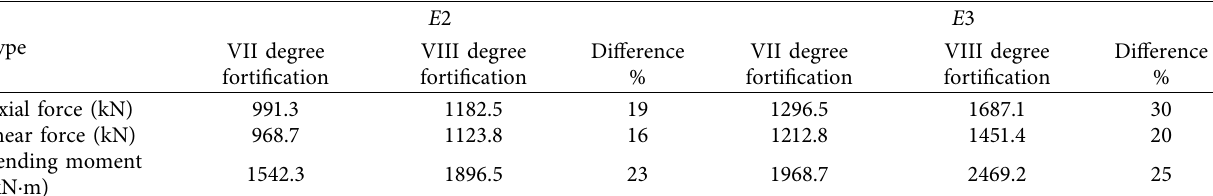
Figure 4: (a) The horizontal displacement and (b) the shearing strain of the station with the E 3 earthquake motion of degree VIII. Table 3: Internal forces of the station structure with different earthquake motions.